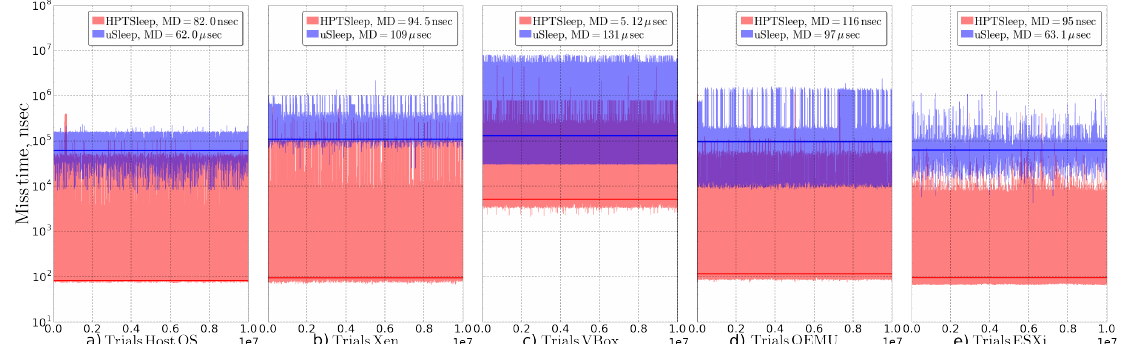
Figure 10. Measurements of miss time for the Idle testbed on: ( a ) Host OS; ( b ) Xen; ( c ) Virtual Box; ( d ) QEMU; and ( e ) VMware